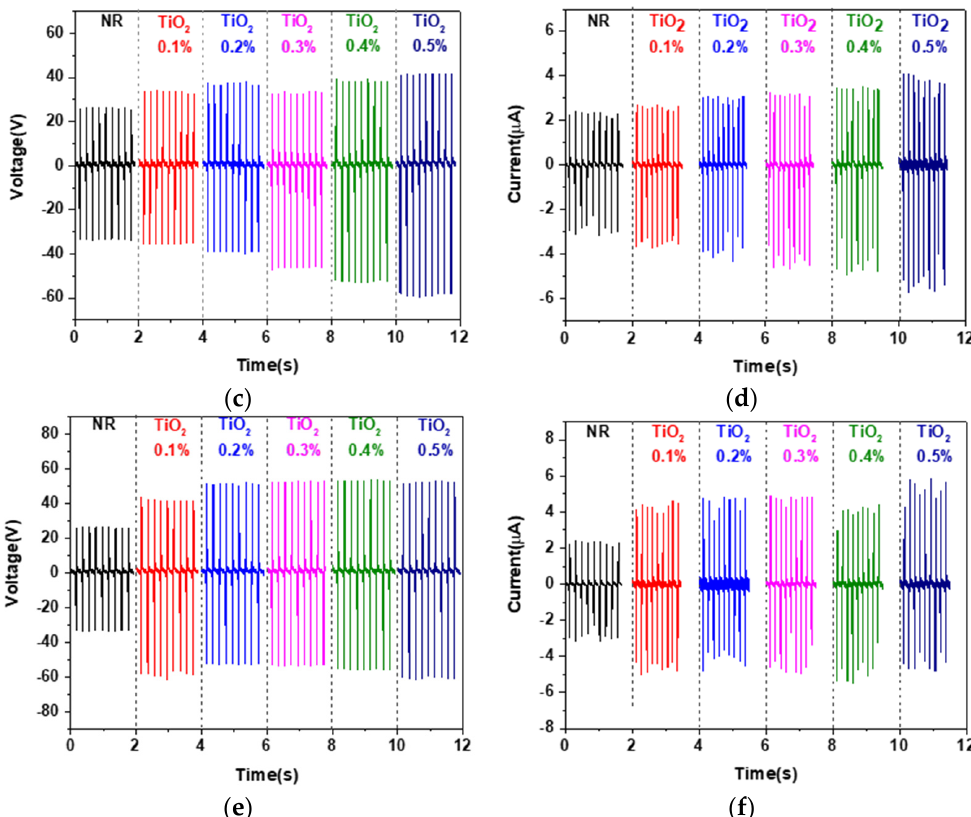
Figure 3. Electrical voltage and current of ( a , b ) NR-TiO 2 -B6h TENG, ( c , d ) NR-TiO 2 -B12h, ( e , f ) NR-TiO 2 -B24h 0.1–0.5%.